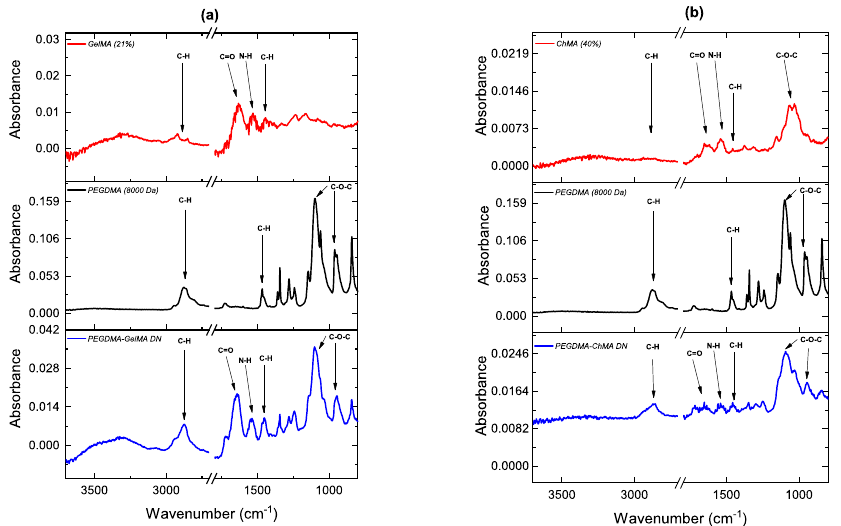
Figure 2. FT-IR spectrum for ( a ) GelMA (21%), PEGDMA (8000 Da) and PEGDMA-GelMA DN, ( b ) ChMA (40%), PEGDMA (8000 Da) and PEGDMA-ChMA DN.